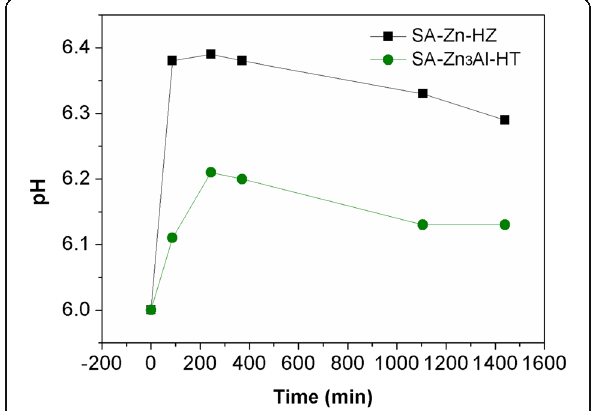
Fig. 8 pH values of the Pb(II) solutions versus time in the adsorption using SA-Zn-HZ and SA-Zn 3 Al-HT as